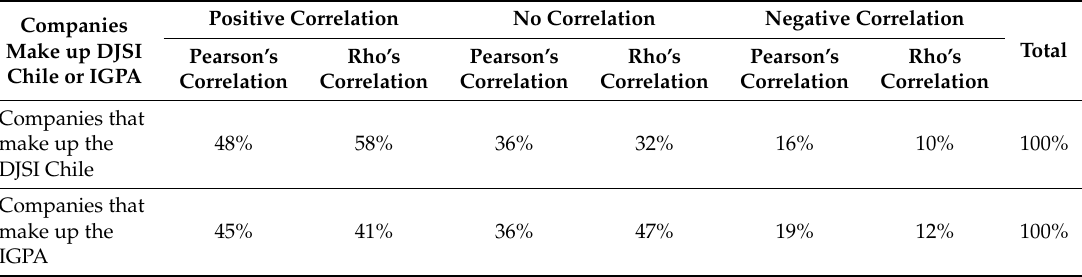
Table 5. Summary of earnings correlation with the DJSI